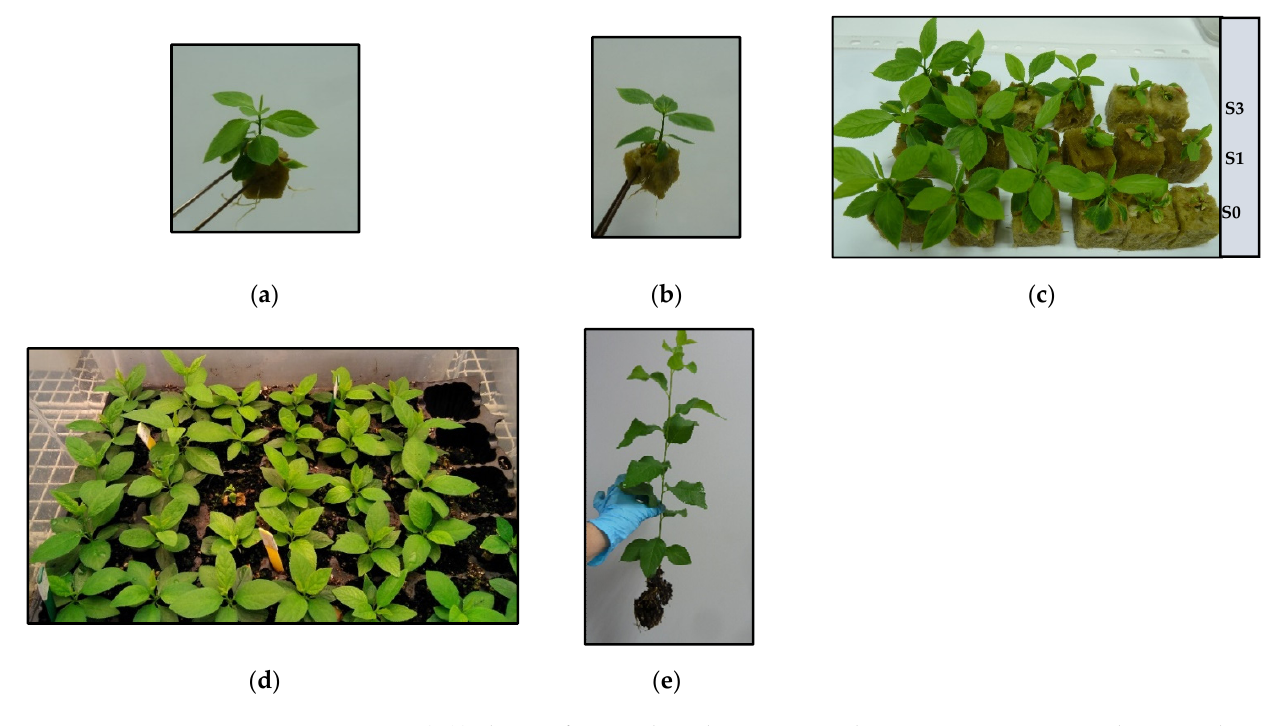
Figure 13. ( a , b ) Shoots of CBP cultured in RITA© without sucrose in PAM conditions and rooted in rockwool cubes soaked with 1% ( a ) and 3% sucrose ( b ); ( c – e ) shoots cultured in ST with 1% sucrose and rooted with 0, 1 and 3% sucrose 6 weeks after root induction ( c ), after 2 weeks in the phytotron ( d ) and after 2 months in the greenhouse ( e ). ST: standard conditions and PAM: photoautotrophic conditions.